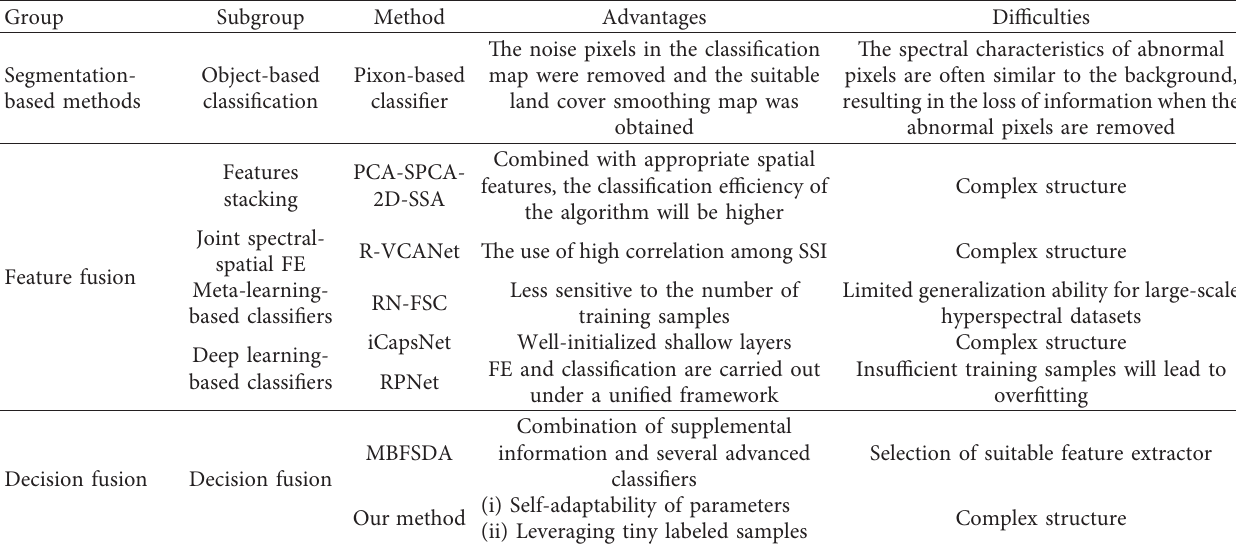
Figure 4: Influence of the spectral band numbers. Table 1: A comparison of different methods for hyperspectral image